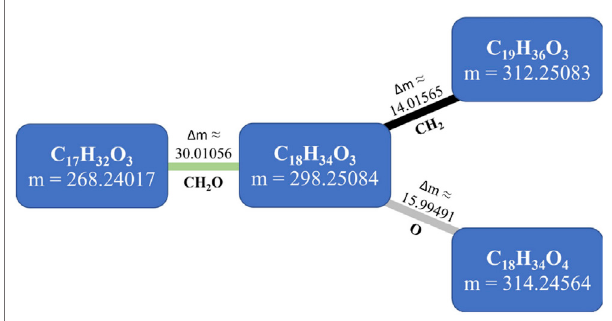
FIGURE 1 | The concept of mass-difference networks (MDiNs). In this four-node example, neutral mass values (in Da) obtained from a mass spectrometry analysis are represented as nodes, connected with mass differences associated with particular mass-difference-based building blocks (MDBs). Δ m, mass difference (in